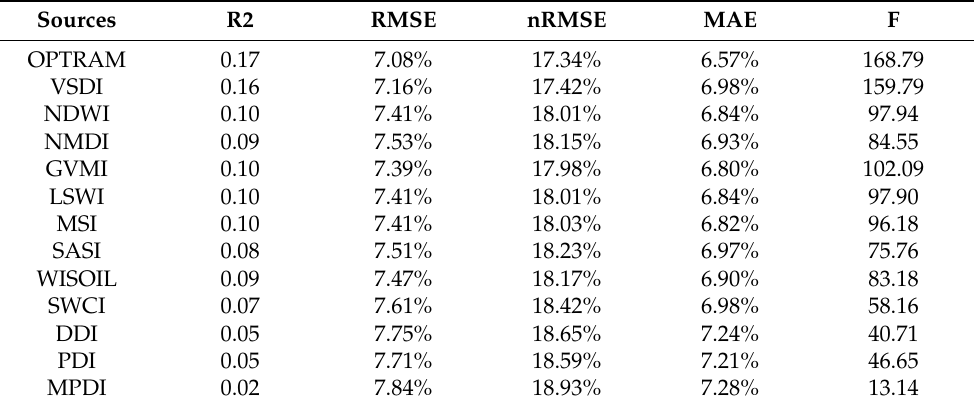
Table 4. Comparisons between in situ SM and optical SMIs with MODIS data.